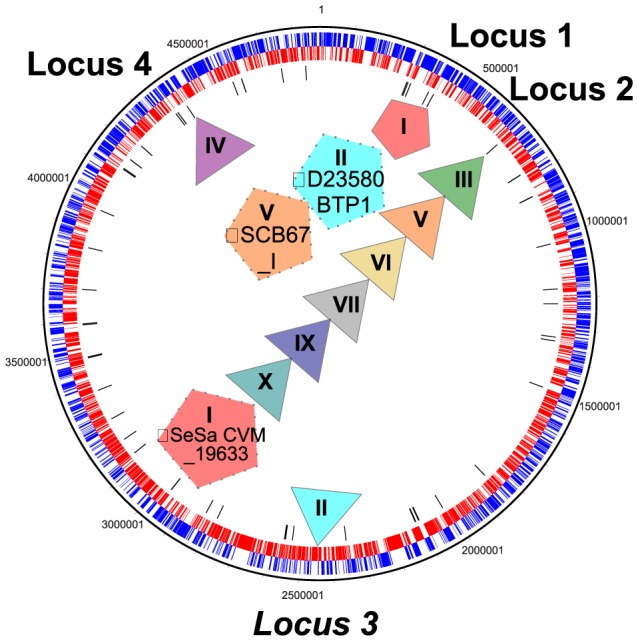
Genome localization ofSalmonella gtr operons.Circular representation of the serogroup B S. Typhimurium D23580 genome (accession number FN424405) indicating that 9 GtrC families localize to four genomic regions (locus 1–4) relative to the D23580 genome. The italicized locus 3 (SPI-17) site is not represented in KW serogroup B genomes and thus, its relative location in S. Typhimurium D23580 is shown. Triangular gtr operons point the common location of GtrC family members. Pentagonal gtr operons are associated with full-length prophage. Dotted pentagonal operons with the phi symbol ‘Φ’ indicate gtr operons associated with full-length prophage that do not localize with their ‘parent’ GtrC family members. Gtr acronyms for these three gtr operons are shown (Table S1). Color code of the pentagon/triangles relate to the GtrC family clustering defined in Figure 1. The circular S. Typhimurium D23580 genome depicts forward open reading frames in blue, reverse open reading frames in red and tRNA in black.